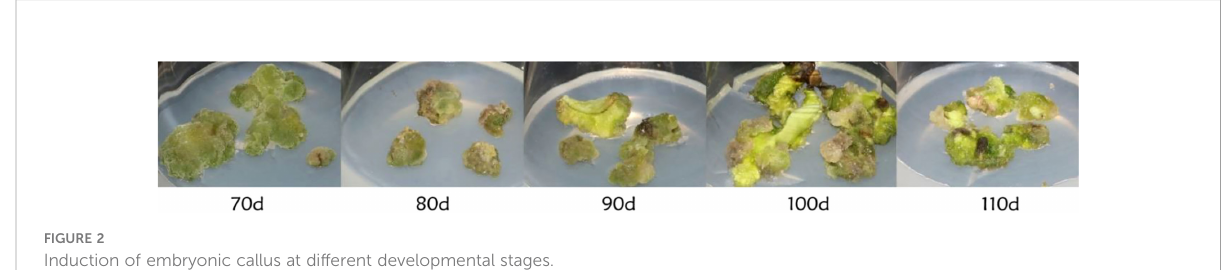
FIGURE 2 Induction of embryonic callus at different developmental